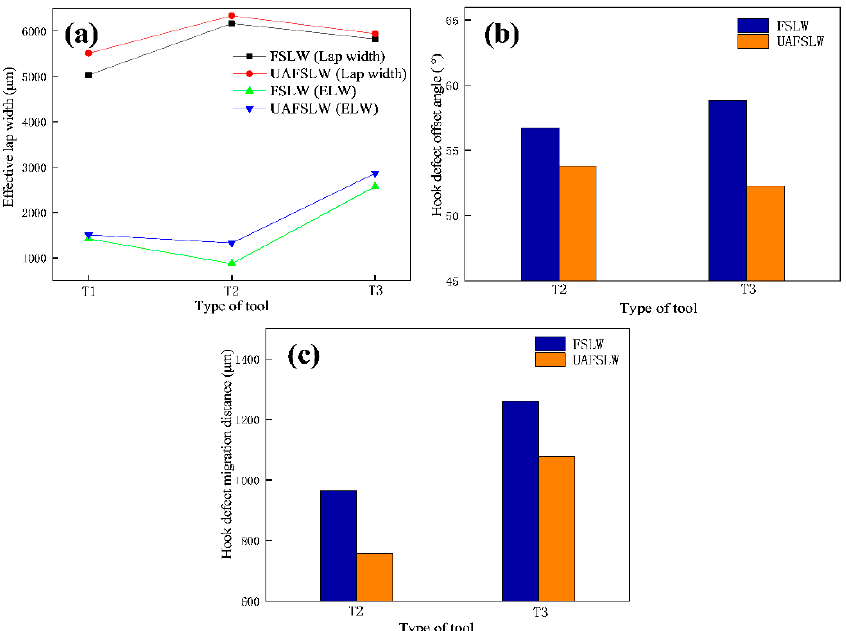
Figure 7. ( a ) Effective lap width (ELW), ( b ) α , and ( c ) H A of the FSLW and UAFSLW joints in Figure 5.